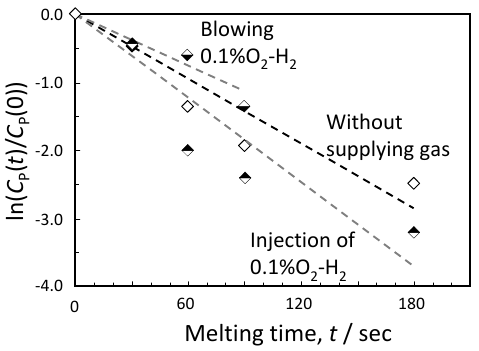
Figure 7. Relation between ln( C P .t/=C P .0// and melting time with blowing and injection of 0.1% O 2 -H 2